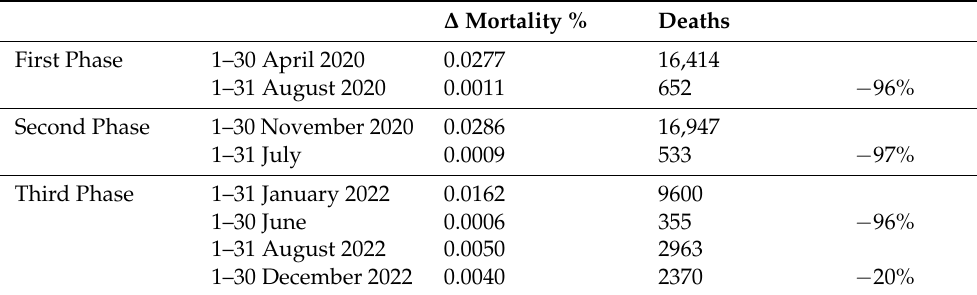
Table 3. Monthly change in Mortality.